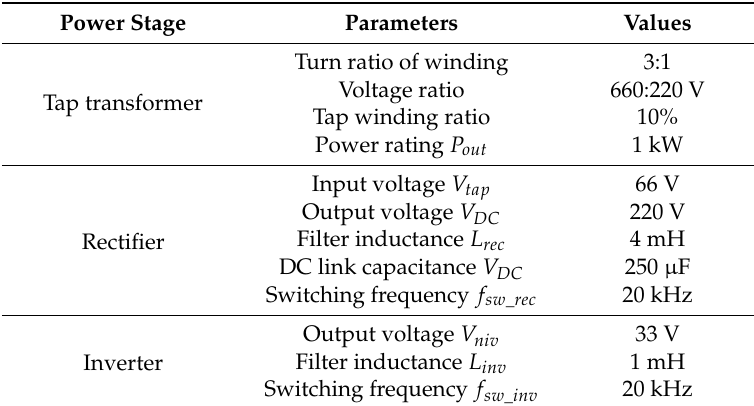
Table 1. Parameters for the simulation.